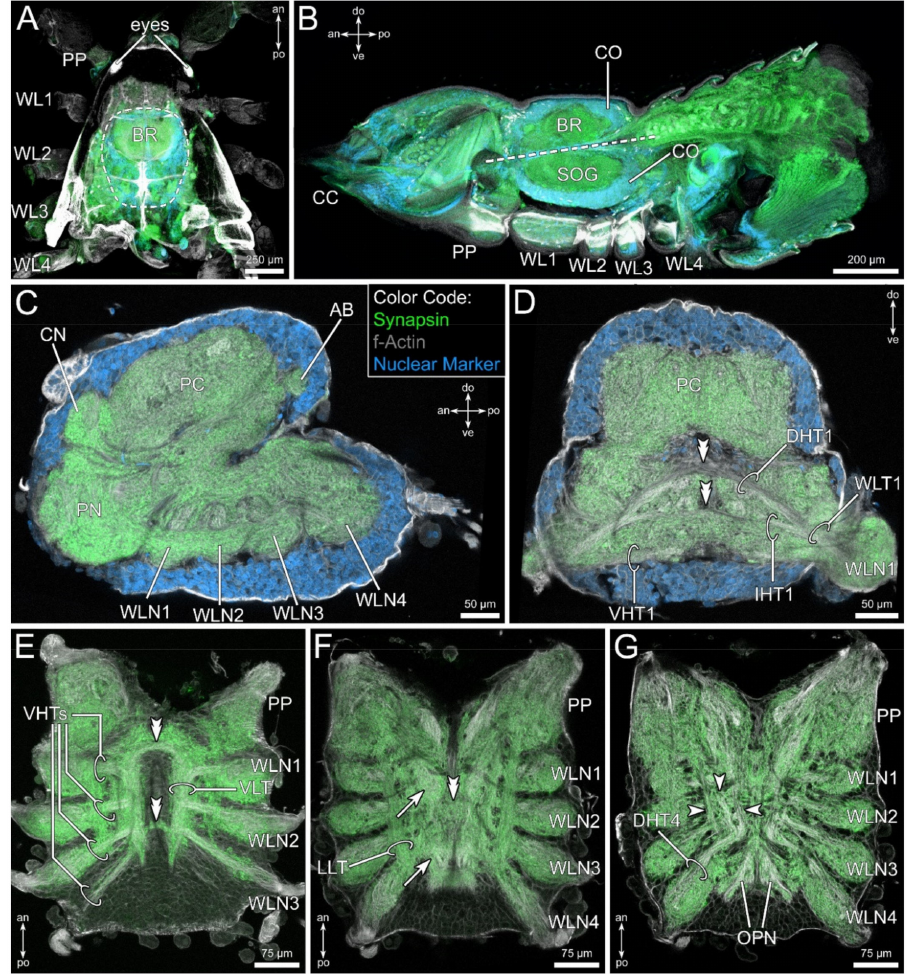
Figure 2. General morphology of the central nervous system of Chelifer cancroides , revealed by fluorescent labeling of synaptic regions (green), f-actin (gray), and cell bodies (blue). ( A ) Position of the synganglion within the prosoma from a dorsal view. The dashed line indicates the outline of the synganglion. ( B ) From a sagittal view at the midline level, the synganglion is positioned at the dorsal margin of the prosoma. The soma cortex (CO) surrounds the neuropilar regions. The synganglion is divided into a supraesophageal brain (BR) and the subesophageal ganglion (SOG). Dashed line indicates the esophagus. ( C ) Sagittal slice of the synganglion at a more lateral level compared to ( B ). Ventrally, the four walking leg neuromeres (WLN1–4) can be recognized. Anterior to the WLN lies the large pedipalpal neuromere (PN). Dorsally to the PN, the cheliceral neuromere (CN) can be distinguished. The main part of the brain consists of the protocerebrum (PC), including the dorso-posterior arcuate body (AB). ( D ) Dorsal section of the synganglion at the level of the first walking leg neuromere (WLN1). A thick fiber tract (WLT1) connects the lateral parts of the WLN1 with medial areas of the synganglion. The WLT1 splits into three branches, a ventral (VHT1), an intermediate (IHT1) and a dorsal horizontal tract (DHT1). At least the IHT1 and the DHT1 seem to contain contralateral projections (double arrowheads). ( E ) Horizontal section of the synganglion at a ventral level. The ventral horizontal tracts of the walking legs (VHTs) are connected to a ventral longitudinal tract near the midline (VLT). Arrowheads point on two commissures formed by the bilateral symmetric VLTs. ( F ) At a more dorsal level, a thick, more lateral longitudinal tract (LLT) appears. Between these bilateral symmetric tracts, paired (arrows) and unpaired midline neuropils (double arrowhead) can be distinguished. ( G ) At an even more dorsal level, the dorsal horizontal tracts of the walking legs split up in several dorsal longitudinal tracts (arrows). Note the fused mass of opisthosomal ganglia (OPN), between the fourth walking leg neuromeres (WLN4). Other abbreviations: an: anterior; CC: chelicera; do: dorsal; po: posterior; PP: pedipalp; ve: ventral; WL1–4: walking legs